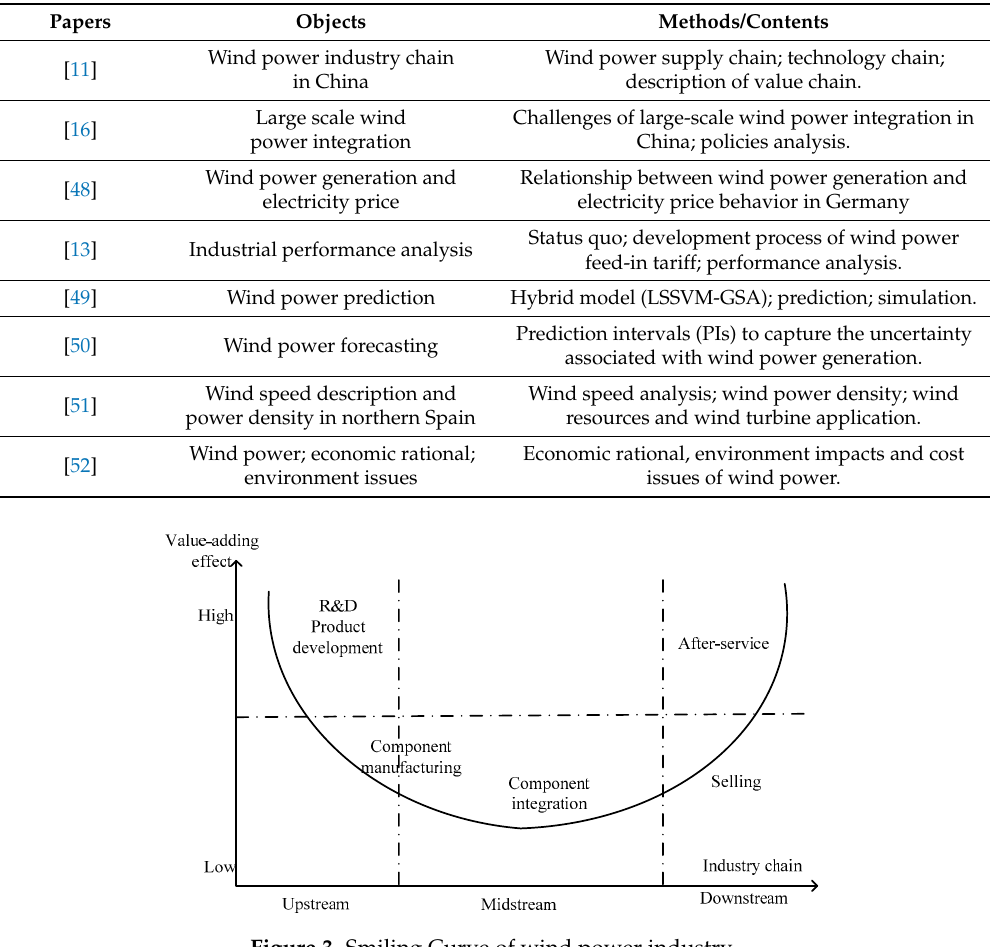
Figure 4. Annual and cumulative installed capacity of wind power in China [8,17,53]. 2006